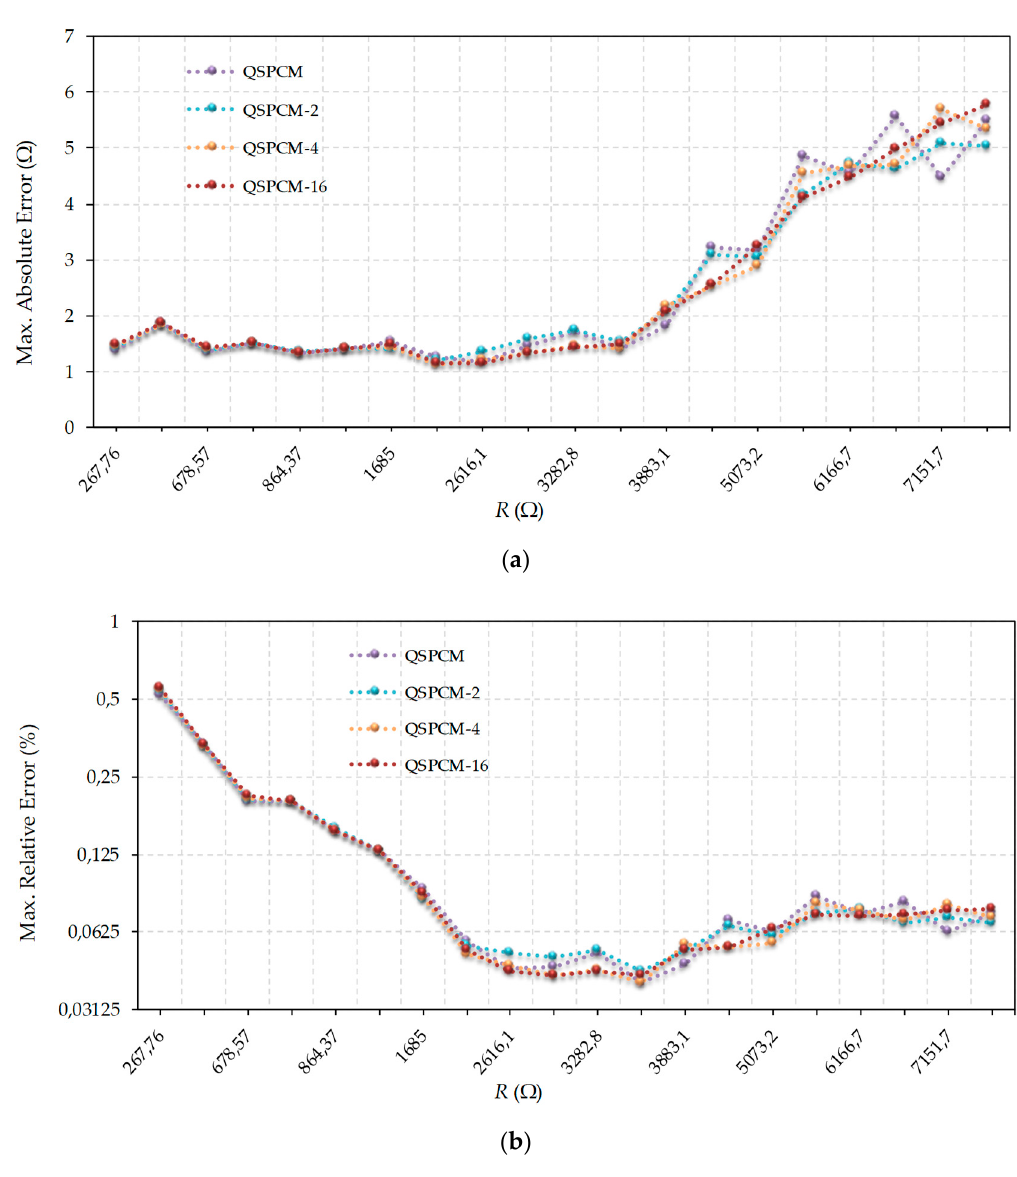
Figure 4. Comparison of errors made in estimating resistance values using the QSPCM and different values of j in QSPCM- j : ( a ) absolute maximum errors (linear scale); ( b ) relative maximum errors (log2 scale).